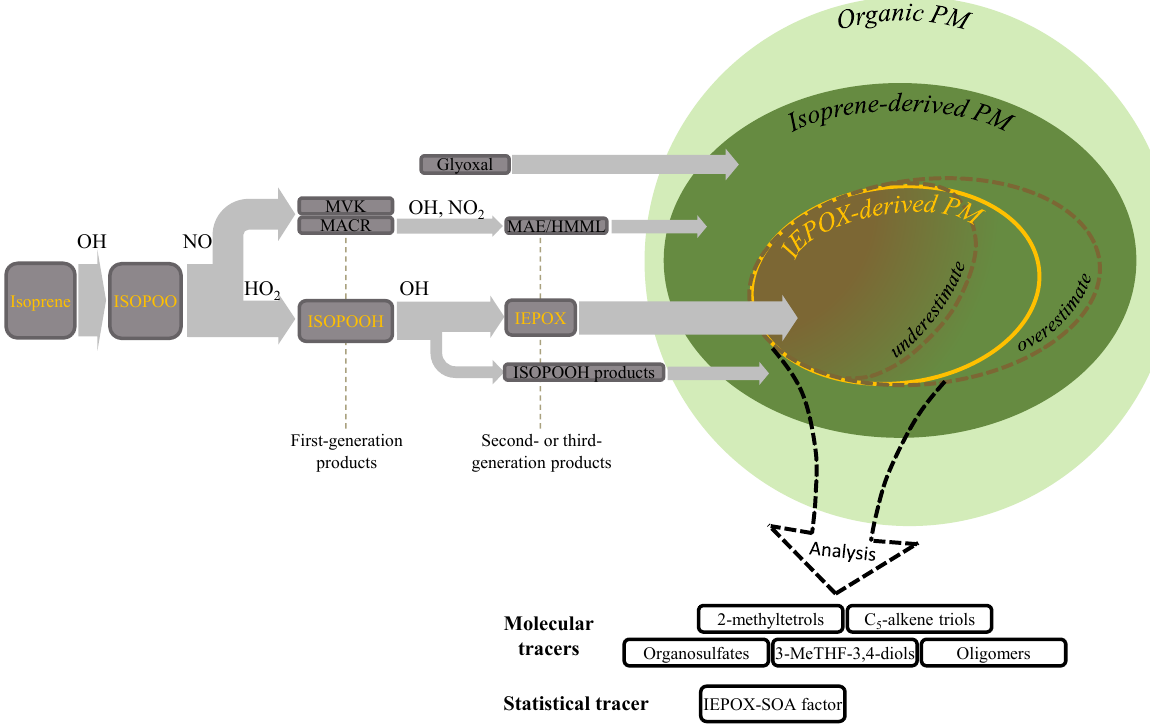
Figure 1. Schematic diagram for the production of PM derived from isoprene epoxydiols (IEPOX) produced during the photooxidation of isoprene. Organic peroxy radicals (ISOPOO), produced by OH attack and O 2 addition to isoprene, are scavenged along NO or HO 2 pathways. By the HO 2 pathway, organic hydroperoxides (ISOPOOH) are first-generation products that react with additional OH to produce IEPOX. The IEPOX species undergo reactive uptake into particles, ultimately producing IEPOX-derived particulate matter. Arrow thickness qualitatively illustrates the relative importance (i.e., mass flux) of a reaction channel under background conditions. Gray and green back- ground colors indicate species in the gas and particle phases, respectively. The light-green disk represents the total organic PM. Within that disk, the contribution by isoprene-derived PM, including compounds produced both IEPOX and non-IEPOX pathways, is represented by the dark-green oval. Inside that oval, the contribution by IEPOX-derived PM is represented by the yellow oval region. The color gradient between brown and dark green illustrates the chemical modification of the IEPOX-derived PM over time. The large dashed black arrow rep- resents the analytical methods that use different types of molecular and statistical tracers (listed in the boxes) to quantify the IEPOX-derived PM mass concentrations. For simplicity, the figure omits the many routes leading to the production of glyoxal (Fu et al., 2008), possible ISOPOO isomerization when NO and HO 2 concentrations are sufficiently low (Crounse et al., 2011; Liu et al., 2016a), second-generation production of peroxymethacrylic nitric anhydride (Lin et al., 2013; Nguyen et al., 2015), and particle water and other inorganic